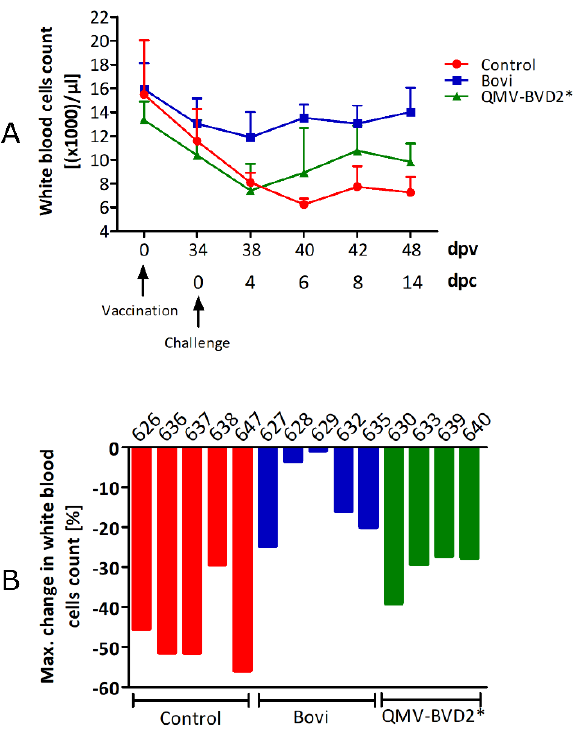
Figure 8. Leukocytopenia after challenge. ( A ) Shown is the mean of the leukocyte count for each treatment group with SD at the indicated days. ( B ) Shown is the mean comparative percent decline in leukocyte numbers for each animal of the 3 treatment groups.